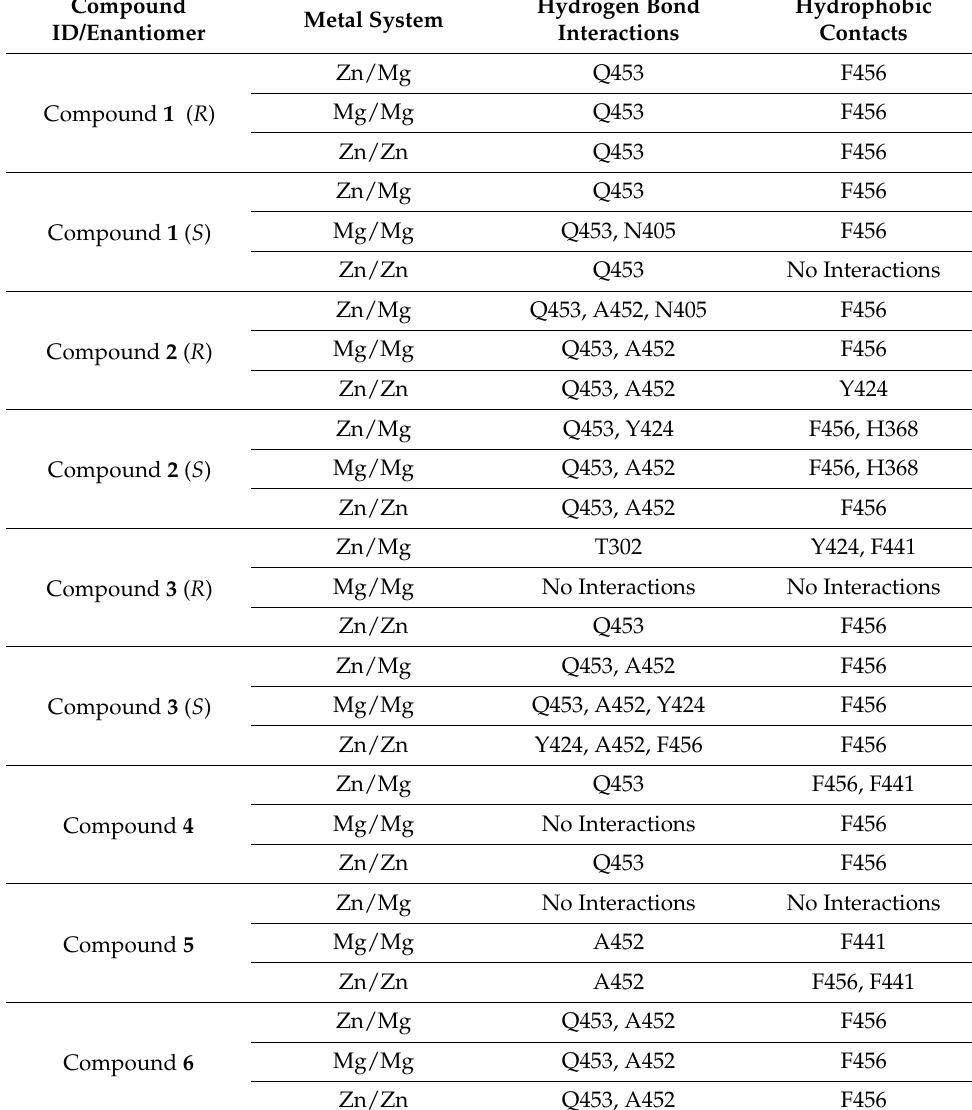
Table 2. Inter-molecular interactions observed in the molecular dynamics studied in different